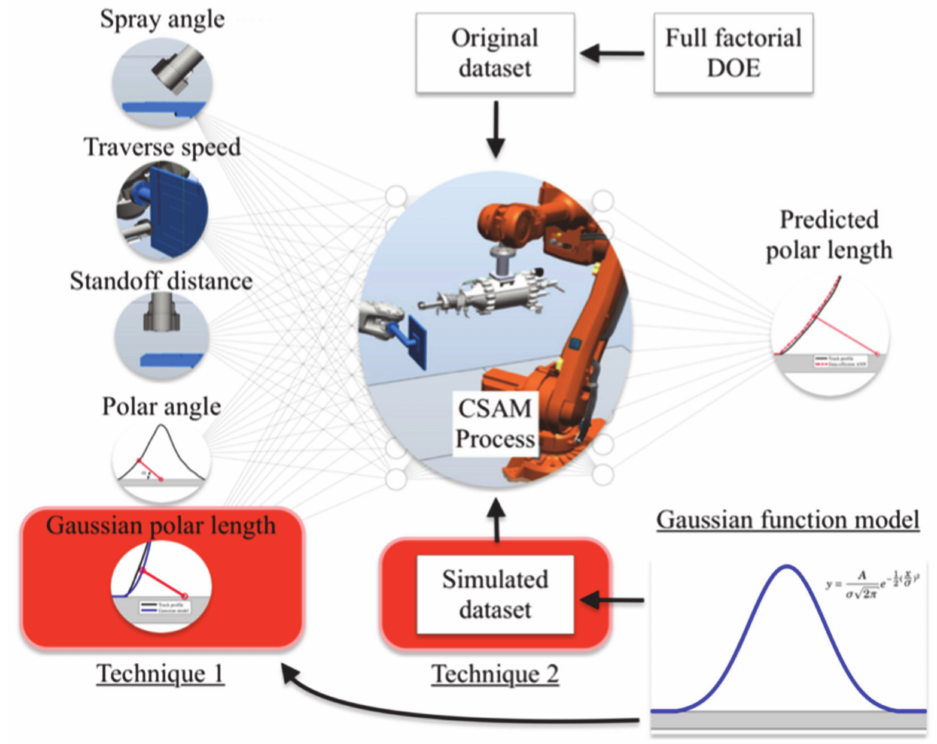
Figure 1. The proposed data-efficient artificial neural network modelling framework for the prediction of a single-track profile in cold spray additive manufacturing. The CSAM process part represents a digital version of the experimental equipment and setup described in Section